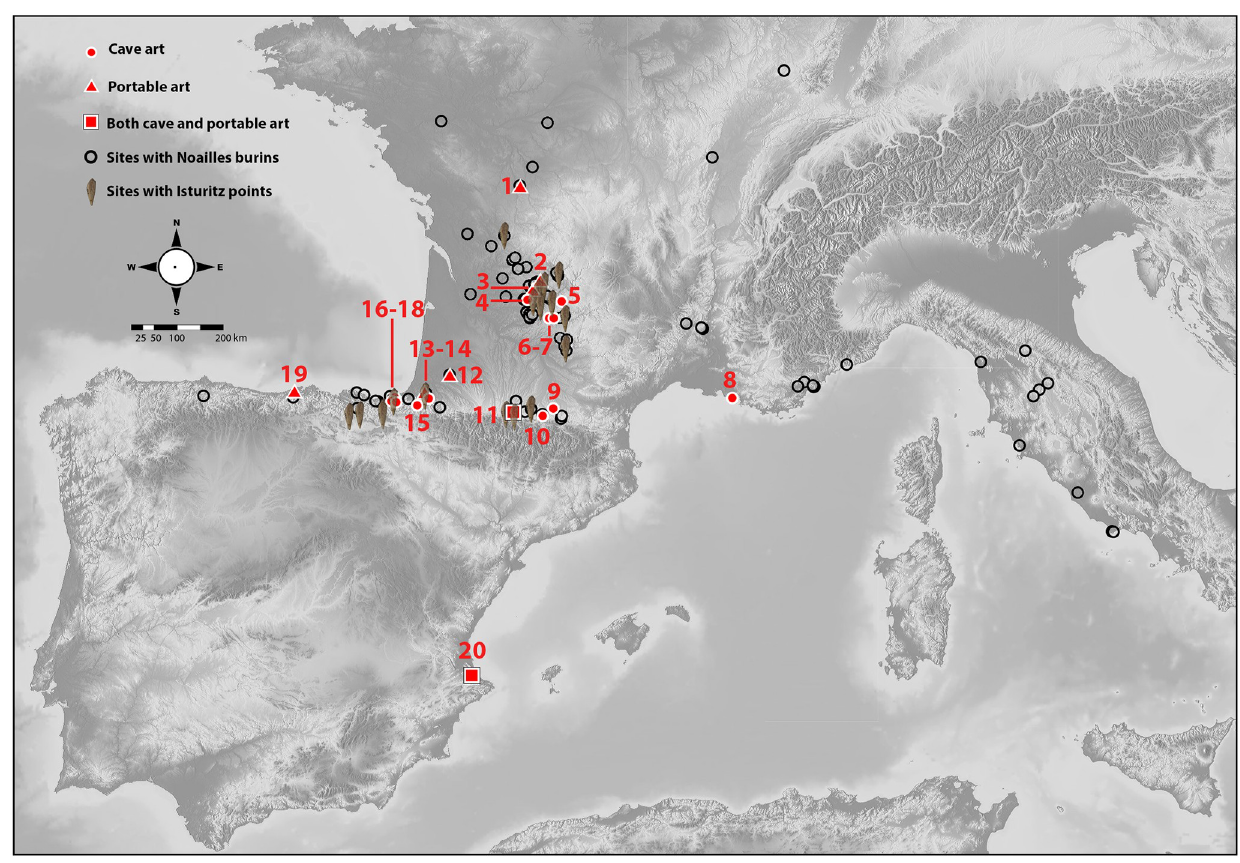
Fig 18. Sites with graphic units in parietal ensembles (circle), on portable objects (triangle) or both (square) (base map: https://maps-for-free.com): 1. Abri Laraux; 2. Abri Labattut; 3. Abri Pataud; 4 Cussac; 5. Roucadour; 6. Pergouset; 7. Pech Merle; 8. Cosquer; 9. Le Portel; 10. Trois-Fr è res; 11. Gargas; 12. Brassempouy; 13. Erberua; 14. Isturitz; 15. Alkerdi 2; 16. Aitzbitarte V; 17. Aitzbitarte III; 18. Aitzbitarte IX; 19. El Pendo; 20. Parpallo´. Sites with Noailles burins (black circle). Sites with Isturitz-type points (icon of a point) (I.